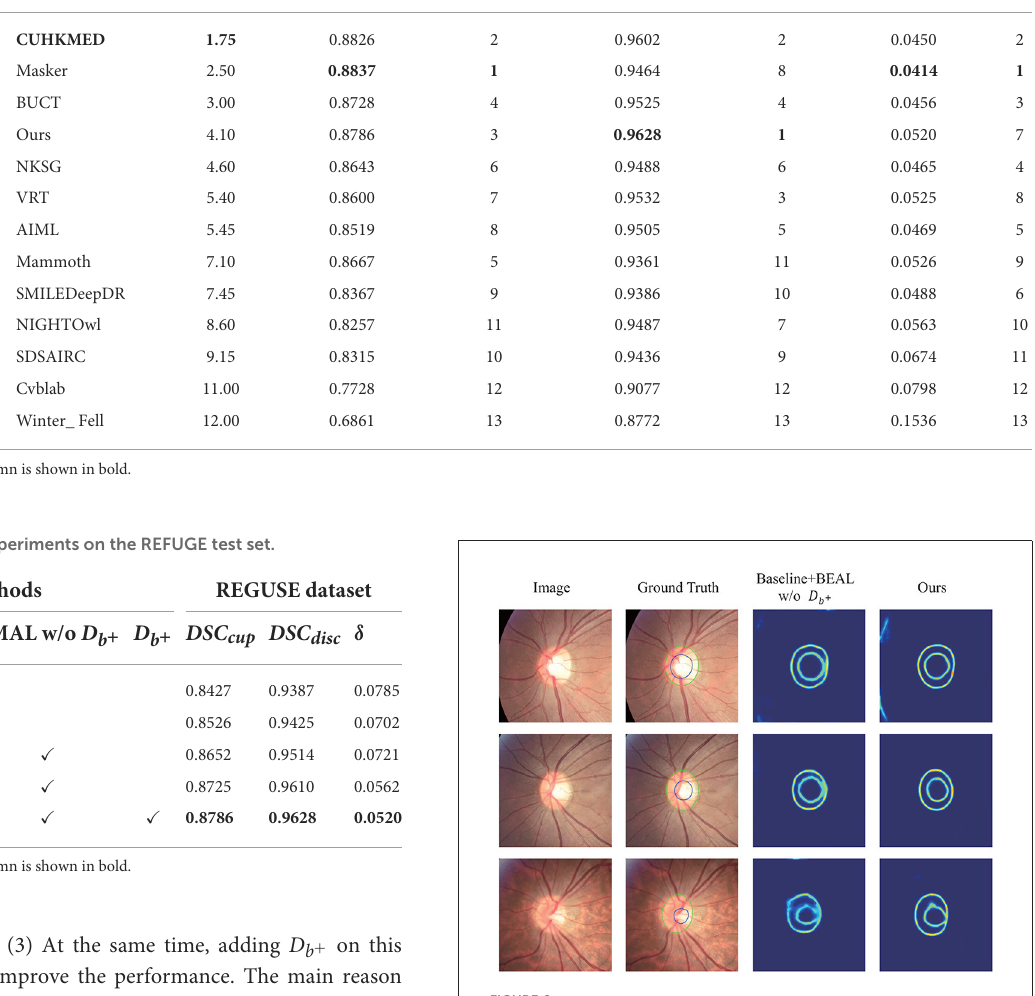
TABLE 4 Cup/disc segmentation results on the REFUGE test set. Overall rank